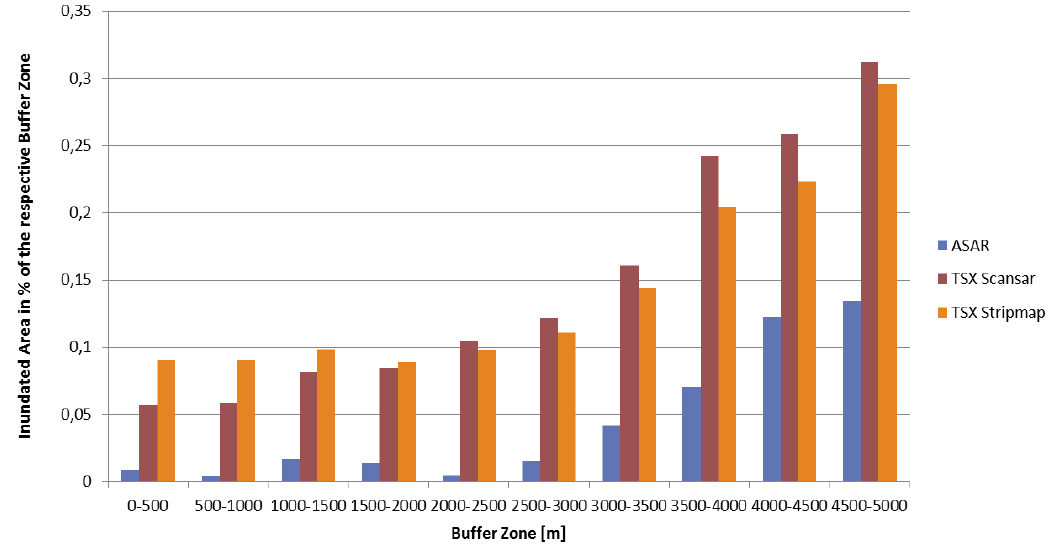
Figure 11. Flooded area in percent of the respective buffer area in the year 2008; as derived from Envisat ASAR WSM, TerraSAR-X Scansar, and TerraSAR-X Stripmap